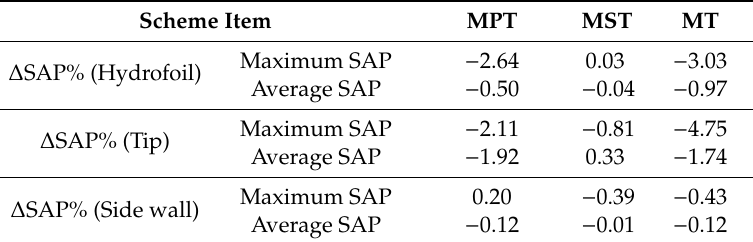
Table 2. Curle SAP for different schemes.